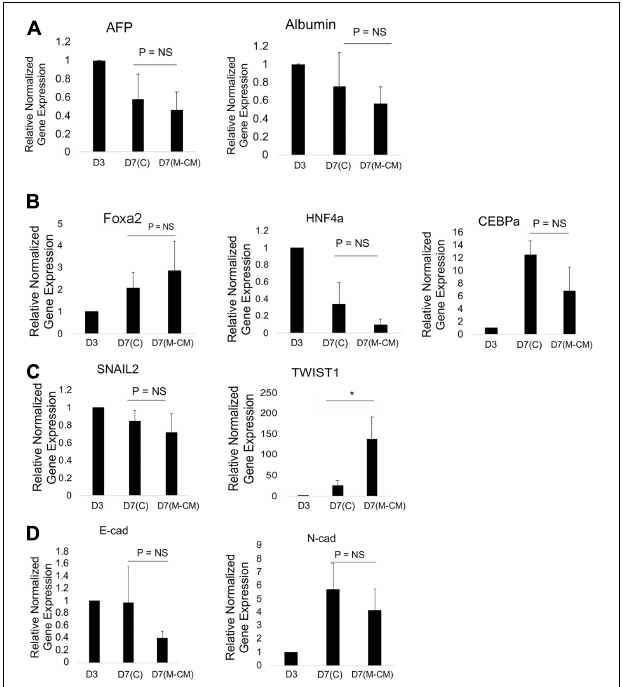
FIGURE 4 | Gene expression analysis of HepG2 spheroids in MG droplets in M-CM. qRT-PCR analysis of HepG2 spheroids on day 3 and after culture in MG droplets with M-CM until day 7. (A) Markers associated with liver differentiation, including alpha-fetoprotein (AFP) ( P = NS, n = 3 for day 7 control, n = 11 for day 7 M-CM), albumin (Alb) ( P = NS, n = 3 for day 7 control, n = 9 for day 7 M-CM) are shown. Plotted is mean ± SD. Significance defined as P ≤ 0.05. (B) Transcription factors in liver development and maturation including Foxa2 [ P = NS ( P = 0.061), n = 3 for day 7 control, n = 5 for day 7 M-CM], HNF4a [ P = NS ( P = 0.25), n = 3 for day 7 control, n = 10 for day 7 M-CM], CEBPa [ P = NS, ( P = 0.103), n = 3 for day 7 control, n = 3 for day 7 M-CM] are shown. Plotted is mean ± SD. Significance defined as P ≤ 0.05. (C) Transcription factors associated with epithelial to mesenchymal transition (EMT) including SNAIL 2 ( P = NS, n = 3 for day 7 control, n = 3 for day 7 M-CM) and TWIST1 ( P = 0.026, n = 3 for day 7 control, n = 4 for day 7 M-CM) were tested. Plotted is mean ± SD. Significance defined as P ≤ 0.05. (D) Cadherin expression associated with EMT, E -cadherin ( E -Cad) [ P = NS ( P = 0.14), n = 3 for day 7 control, n = 4 for day 7 M-CM] and N -cadherin ( N -Cad) expression ( P = NS, n = 4 for day 7 control, n = 4 for day 7 M-CM). Plotted is mean ± SD. Significance defined as P ≤ 0.05. ∗ is used to denote significance of experimental